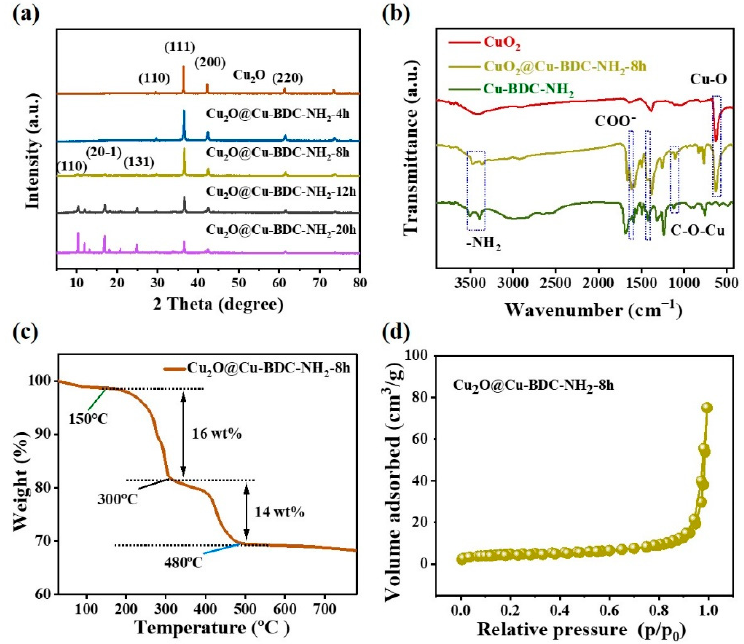
Figure 2. ( a ) XRD patterns of Cu 2 O, Cu 2 O@Cu-BDC-NH 2 -4h, Cu 2 O@Cu-BDC-NH 2 -8h, Cu 2 O@Cu- BDC-NH 2 -12h, and Cu 2 O@Cu-BDC-NH 2 -20h. ( b ) FTIR spectra of Cu 2 O, Cu 2 O@Cu-BDC-NH 2 -8h, and Cu-BDC-NH 2 . ( c ) The TGA curves and ( d ) N 2 adsorption–desorption isotherms of Cu 2 O@Cu- BDC-NH 2 -8h.